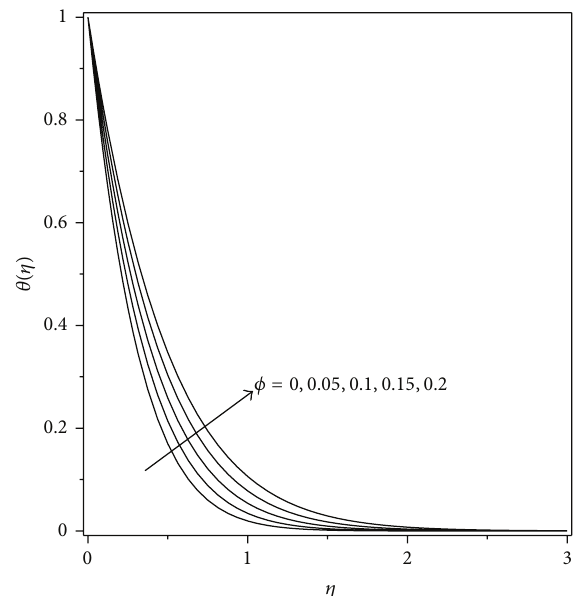
Figure 11: Dimensionless velocity profiles 𝑓 󸀠 (𝜂) for TiO 2 nanopar- ticles with 𝑚 = 0 and various values of 𝜙